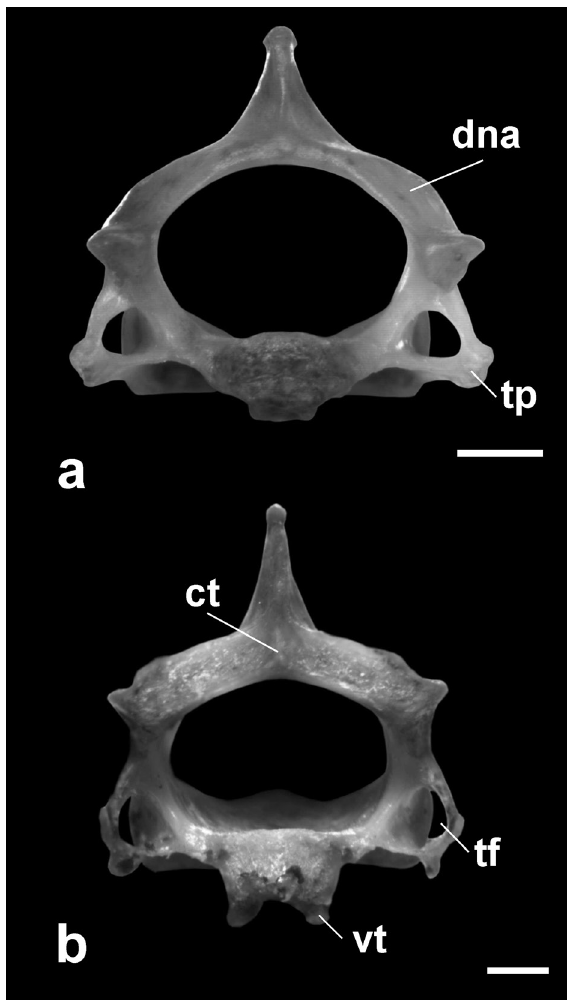
Figure 5 - Posterior view of axis: a . Desmodus rotundus : neural arch simple; b . Chrotopterus auritus : neural arch with a central tubercle and two concavities. Acronyms: ct: central tubercle; dna: dorsal neural arch; tf: transverse foramen; tp: transverse process; vt: ventral tubercle. Scale bar represents 1